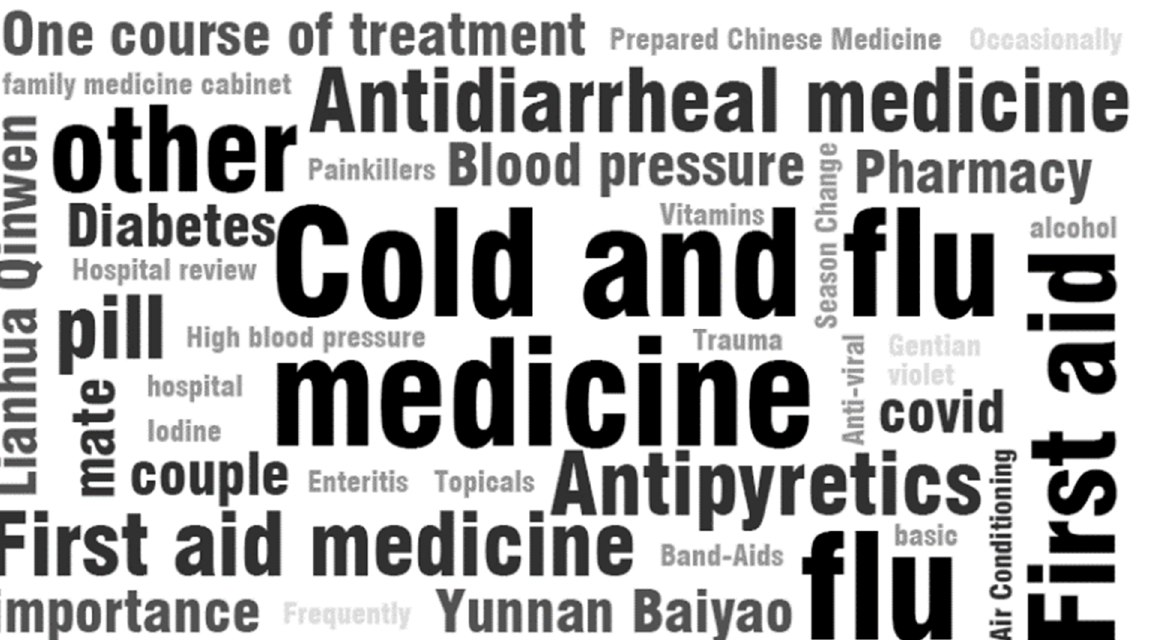
Figure 4. Word cloud generated based on interview results. Table 6. Summary and analysis of user interview results.